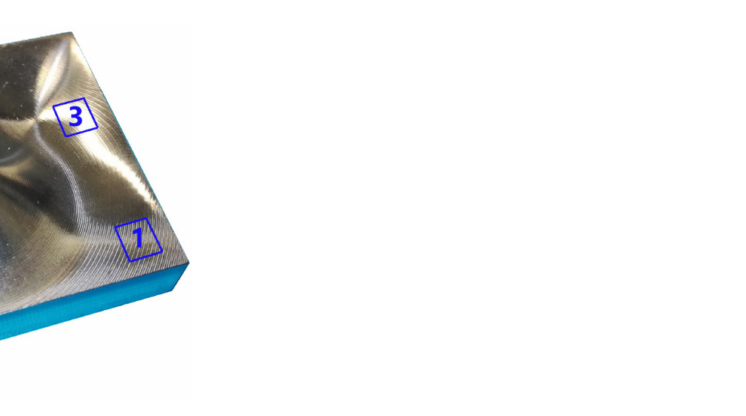
Figure 7. Sample with marked locations for microscopic scanning and surface roughness measurement.